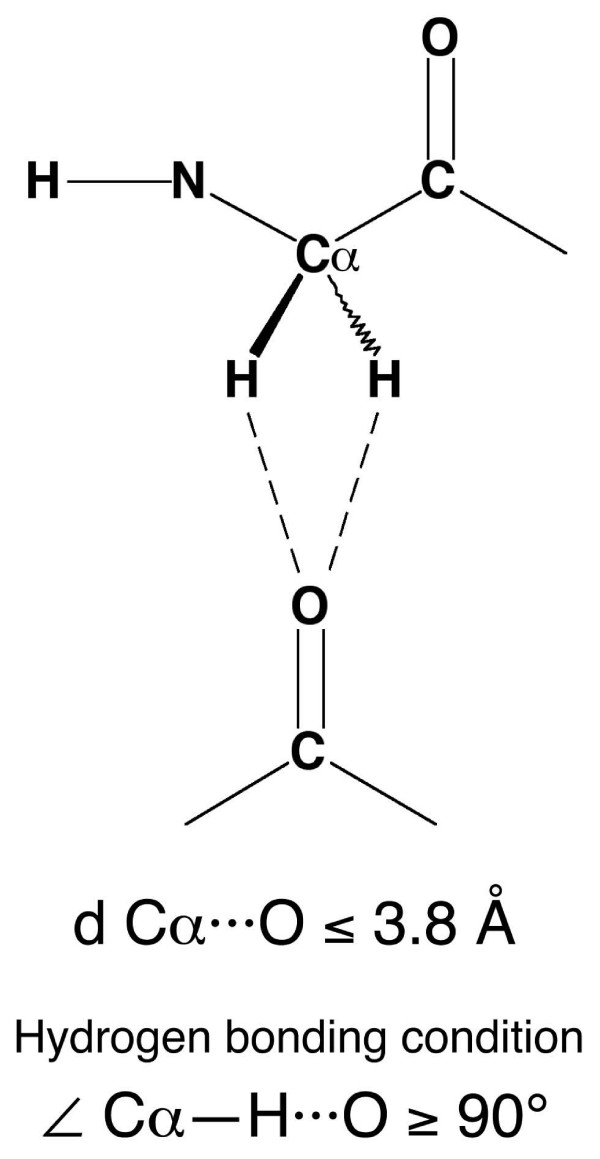
Fragments used in searches for non-bonded interactions in the Cambridge Structural Database [44]. Å 3.8 Å Cα···O distance cutoff was applied in all searches. A hydrogen atom was deemed to be in hydrogen bonding position if the angle Cα-H···O ≥ 90°. Separate searches were conducted for the bifurcated hydrogen bond (both angles ≥ 90°), single Cα-H···O=C hydrogen bond (one angle ≥ 90°, the other < 90°) and no hydrogen bonds (both angles < 90°).